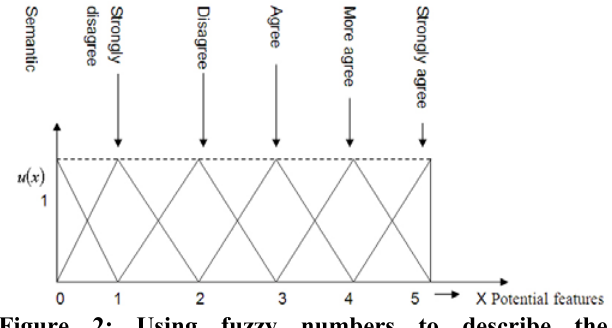
Figure 2: Using fuzzy numbers to describe the relationships between